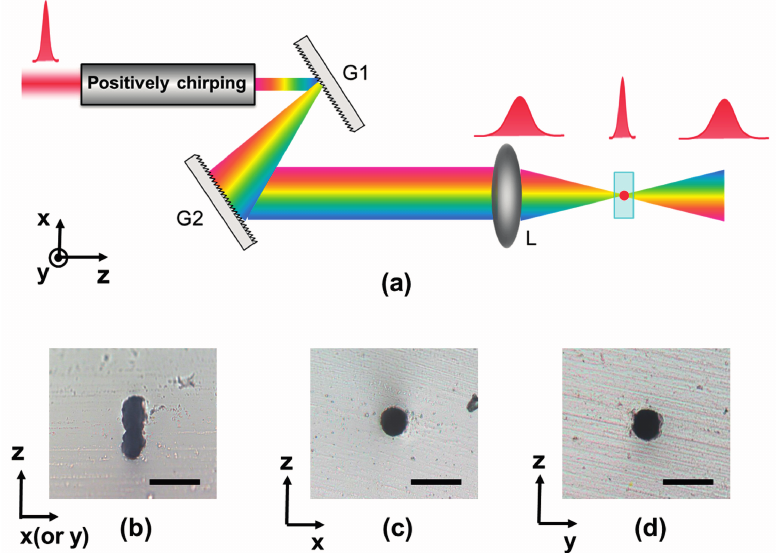
Figure 6. ( a ) Schematic diagram of spatiotemporal focusing for materials processing. The images are cross-sectional optical micrographs of microfluidic channels fabricated in fused silica by FsLDW with ( b ) conventional focusing (XZ or YZ plane); ( c ) spatiotemporal focusing (XZ plane) and ( d ) spatiotemporal focusing (YZ plane) [76] (Reproduced with permission from OSA. © 2010 by the Optical Society of America). The scale bars in ( b – d ) represent 50